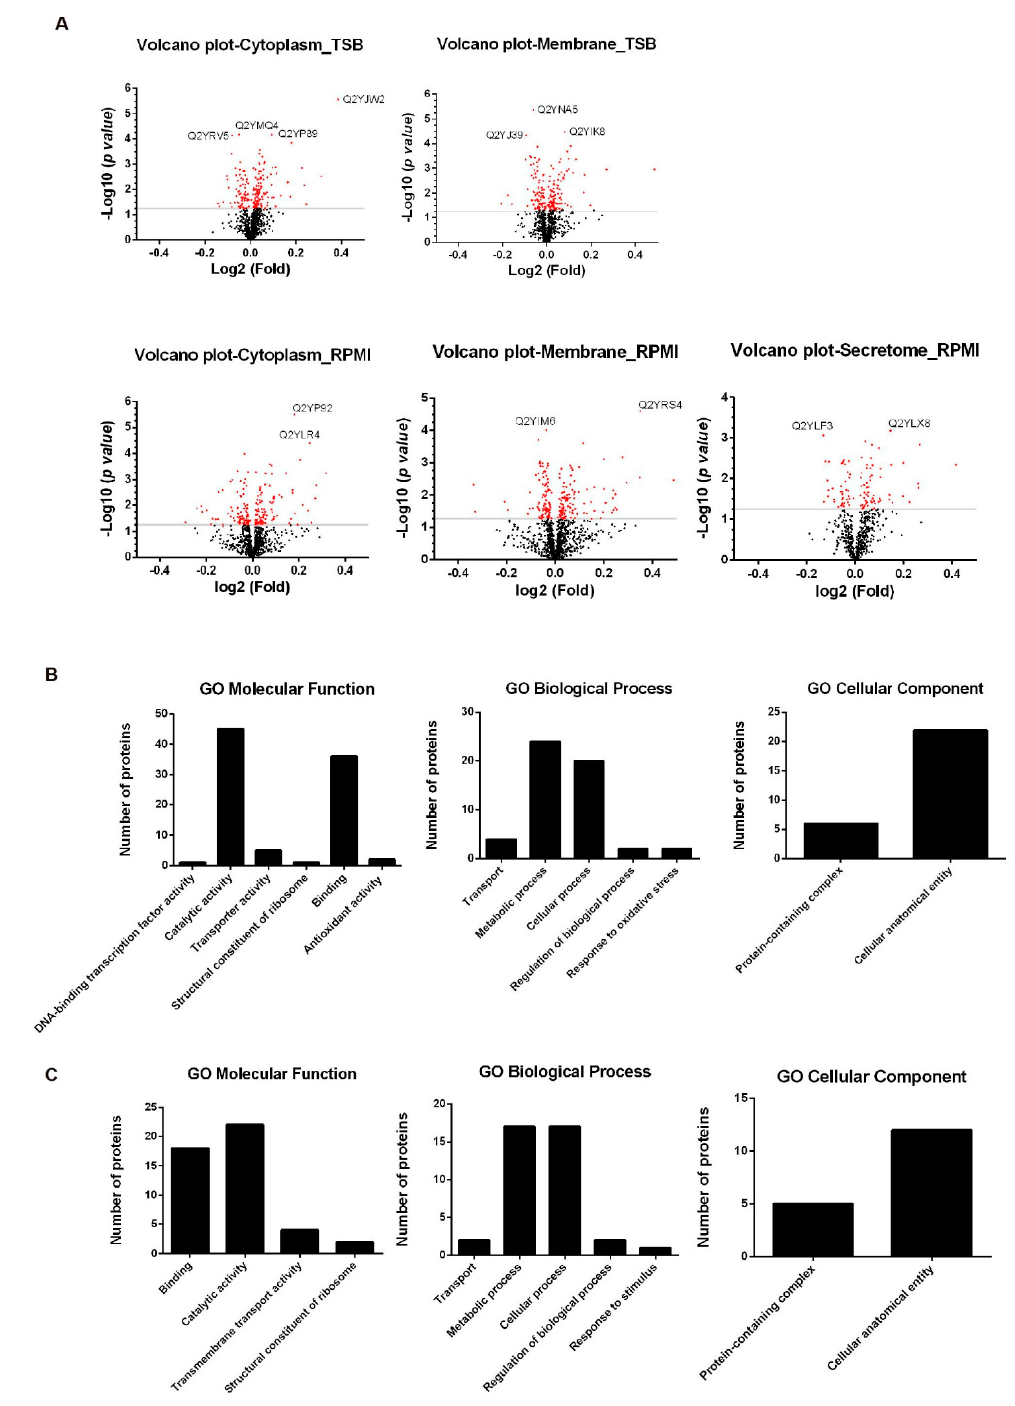
Figure 6. Graphical representation of quantitative proteomics data. ( A ) Total detected proteins from the indicated fractions of TSB- and RPMI-grown bacteria are ranked in volcano plots. Each data point represents a single unique protein identified in our proteomic analysis. Black indicates no significant change and red indicates significant (negative and positive) changes. Labels indicate proteins with lower statistical p values (higher significance). Gene ontology (GO) analysis of dif- ferentially represented proteins between wild type and ∆ rhoX strains in TSB ( B ) and RPMI-grown bacteria ( C ). GO annotation results were divided into biological processes, cellular components, and molecular